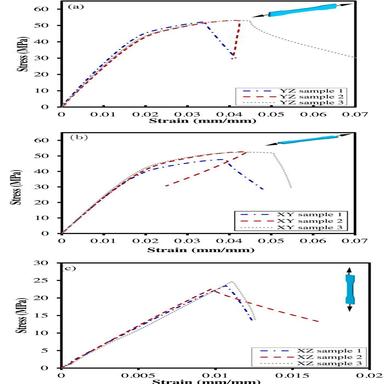
Stress-Strain diagram of FGM printed specimens in (a) YZ, (b) XY, (c) XZ orientations.